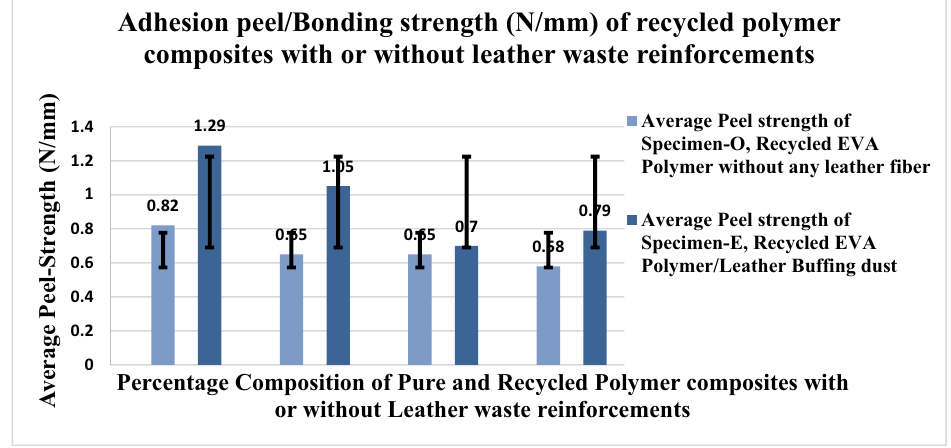
Figure 39: Comparison of adhesion peel strength ( N/mm ) of recycled EVA polymer composites with or without leather bu ffi ng